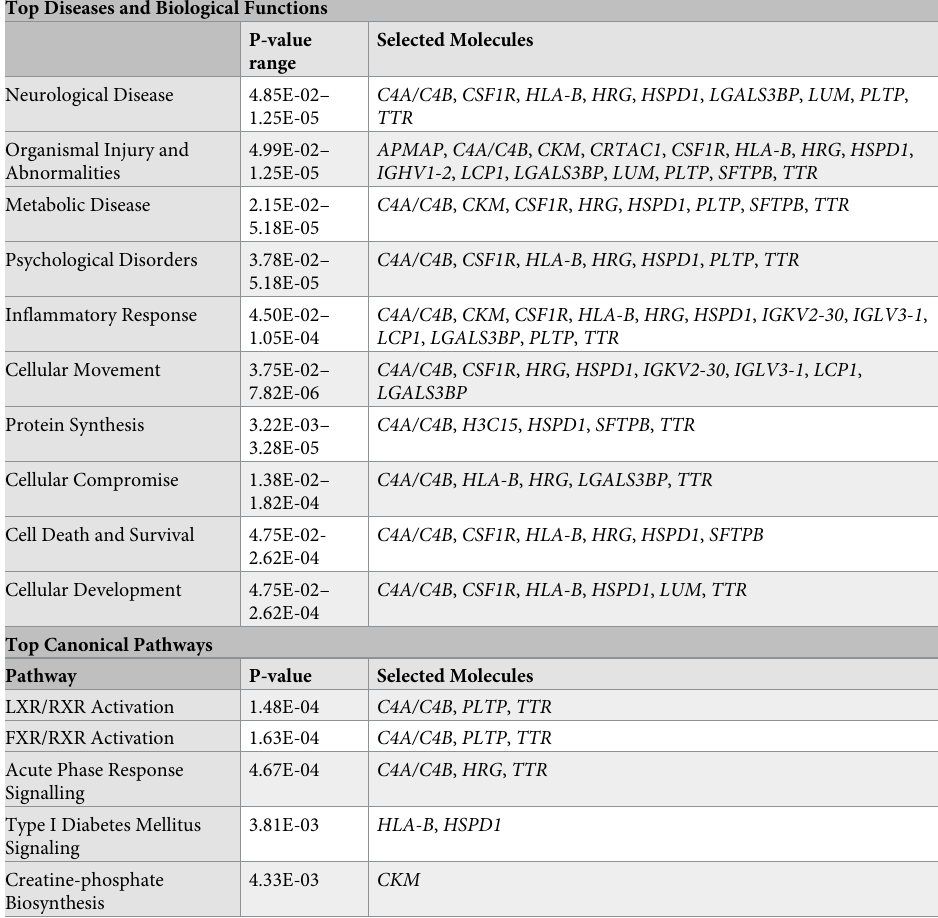
Table 3. Enrichment analysis of proteins associated with COVID-19